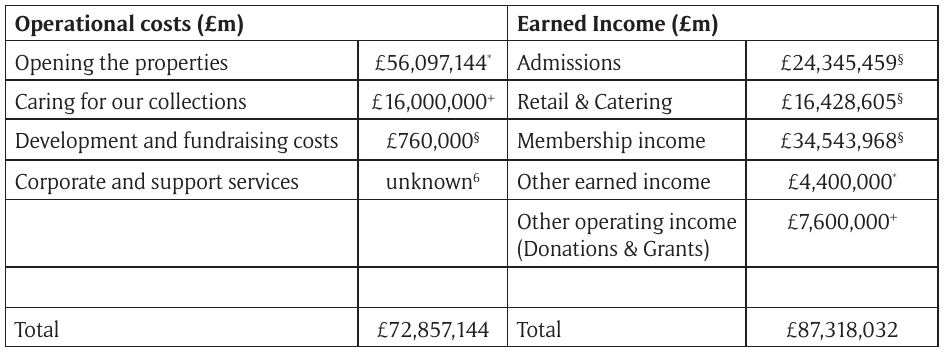
* Figure extrapolated from 2012/13 figures with inflation applied + Figure directly stated in consultation document § Figure extrapolated from data in consultation Table 2: Speculative estimates for revenue and expenditure of the new charity, 2022/23.